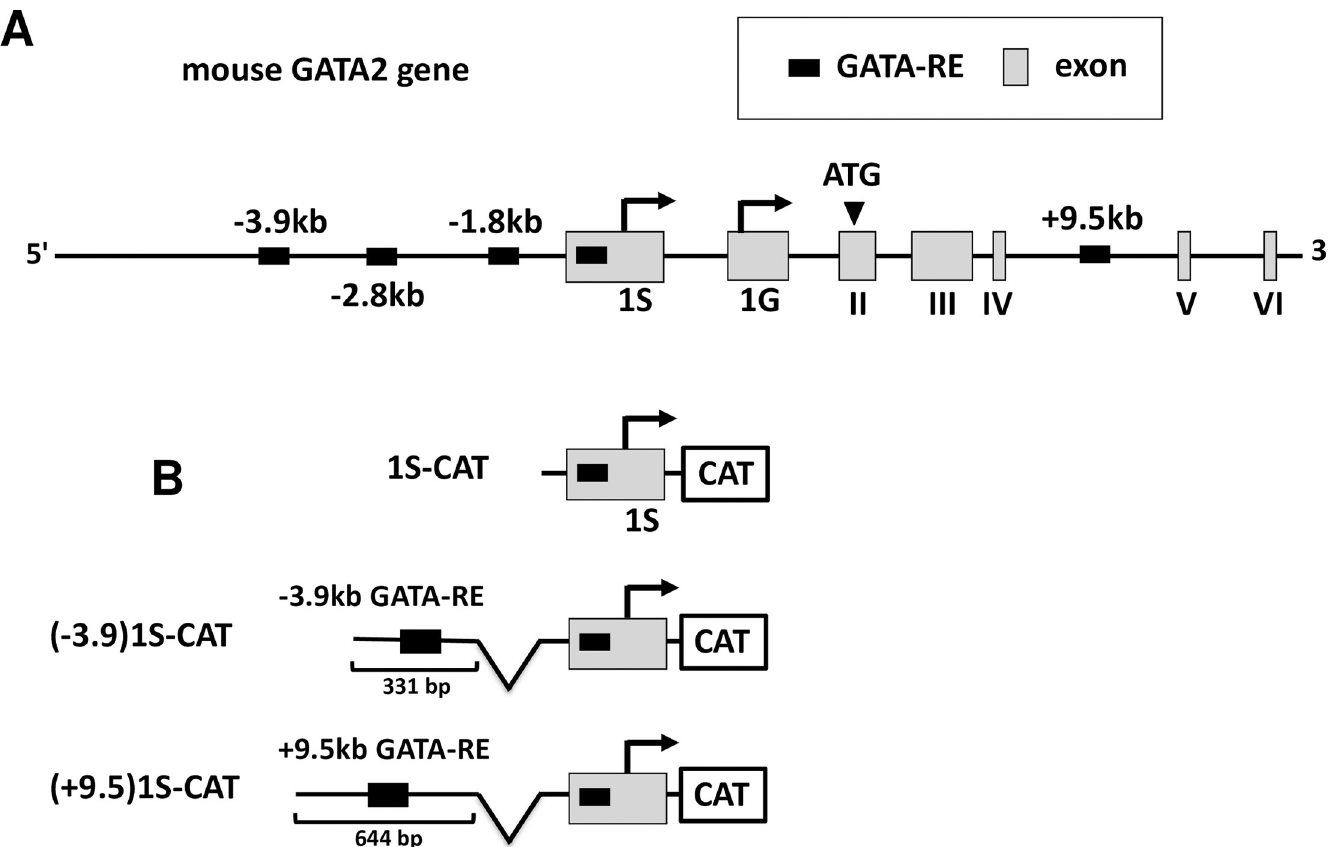
Fig 1. Structures of the mouse GATA2 gene and CAT-reporter genes. (A) In the mouse GATA2 gene, there are at least four GATA-REs as well as two promoters (1S and 1G) that are regulated by these GATA-REs. 1S-promoter may also contain a functional GATA-RE (see main text). (B) 1S promoter, promoter fused with -3.9 GATA-RE or promoter fused with +9.5 GATA-RE were subcloned to the CAT reporter gene to generate 1S-CAT, (-3.9)1S-CAT and (+9.5)1S-CAT,